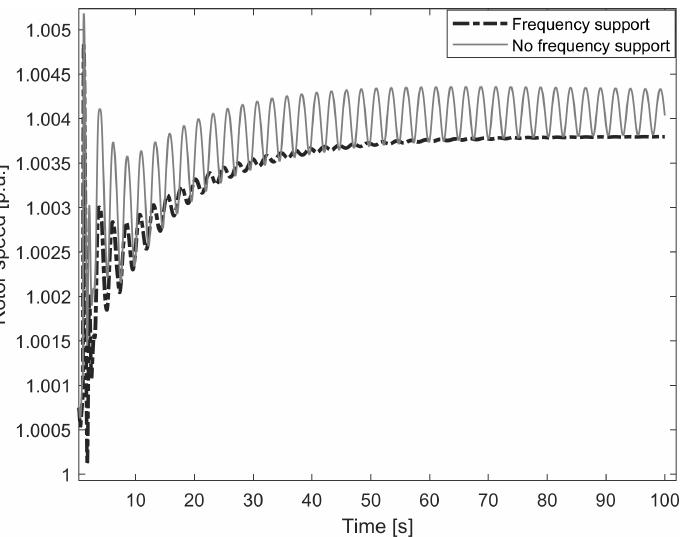
Figure 9. Rotor speed of generator G 3 with and without primary frequency support by a wind